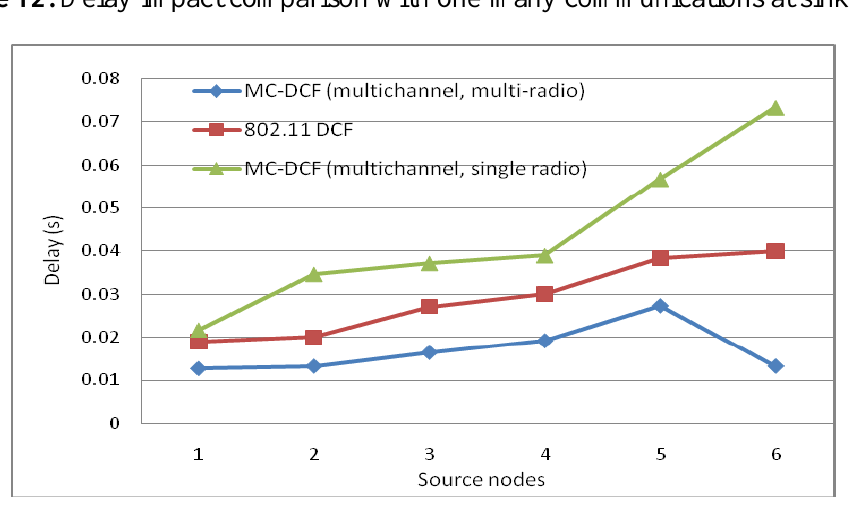
Figure 12. Delay impact comparison with one-many communications at sink node.